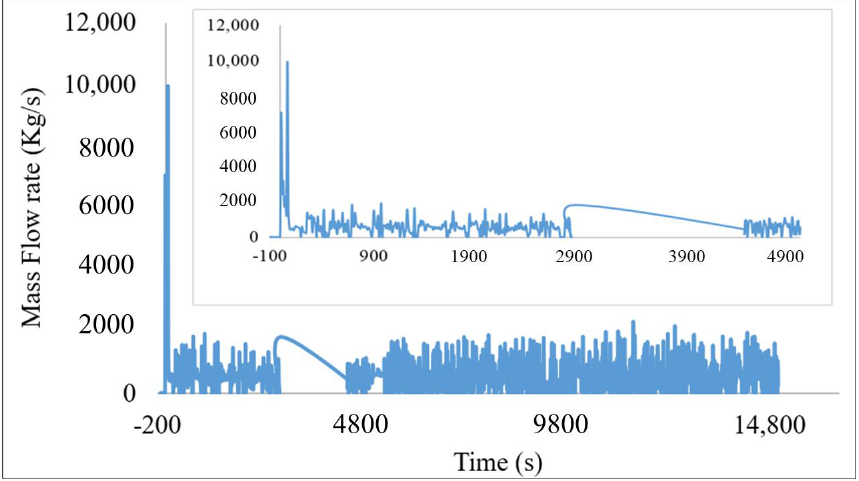
Figure 4. Mass flow rate through the leakage.